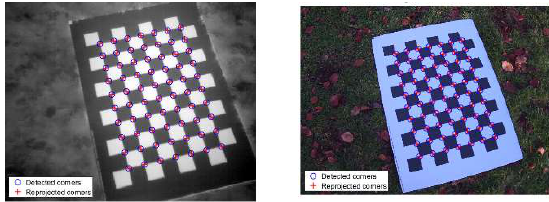
Figure 4. DJI Zenmuse XT2 images of calibration test field. Left: TIR image, right: visible